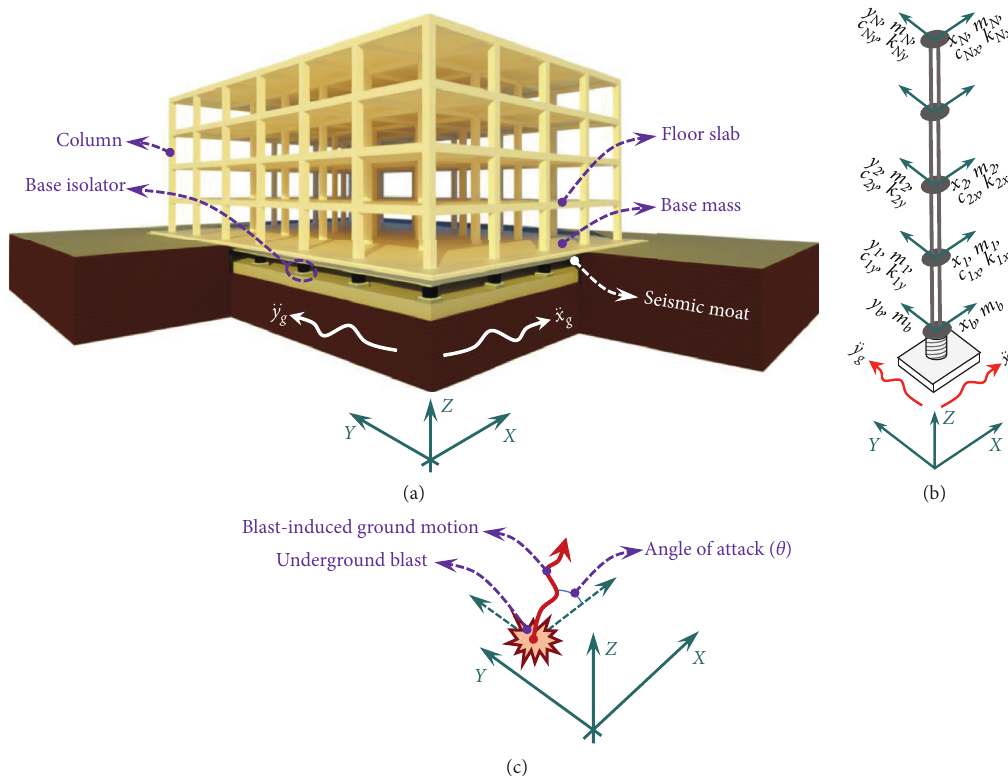
Figure 1: Base-isolated building subjected to bidirectional base excitation: (a) schematic diagram, (b) idealized model, and (c) blast-induced ground motion